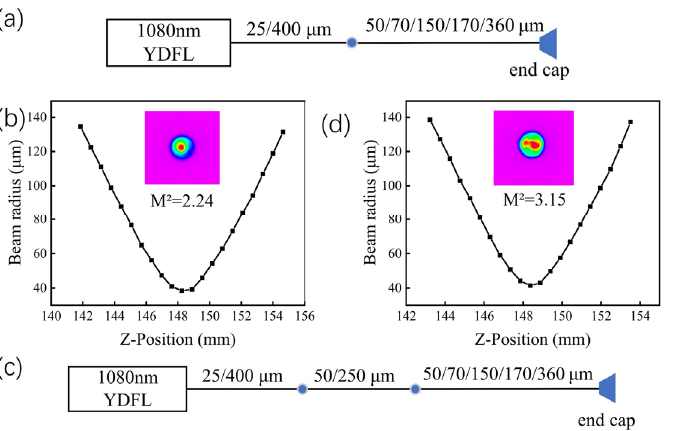
Figure 5. The test diagram and the output beam quality when the laser is directly transmitted into the end cap and the laser is transmitted into the end cap through a single 50/250 μ m fiber. ( a ) The diagram when the laser is directly transmitted into the end cap; ( b ) The output beam quality when the laser is directly transmitted into the end cap; ( c ) The diagram when the laser is transmitted into the end cap through a single 50/250 μ m fiber; ( d ) The output beam quality when the laser is transmitted into the end cap through a single 50/250 μ m fiber.